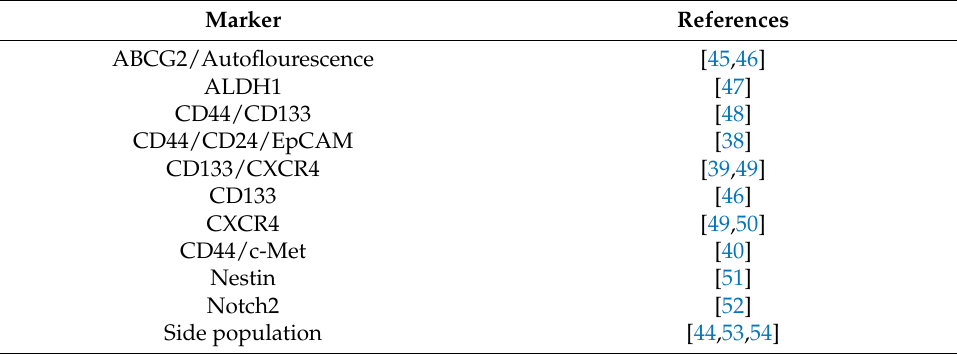
Table 1. Pancreatic cancer stem cells